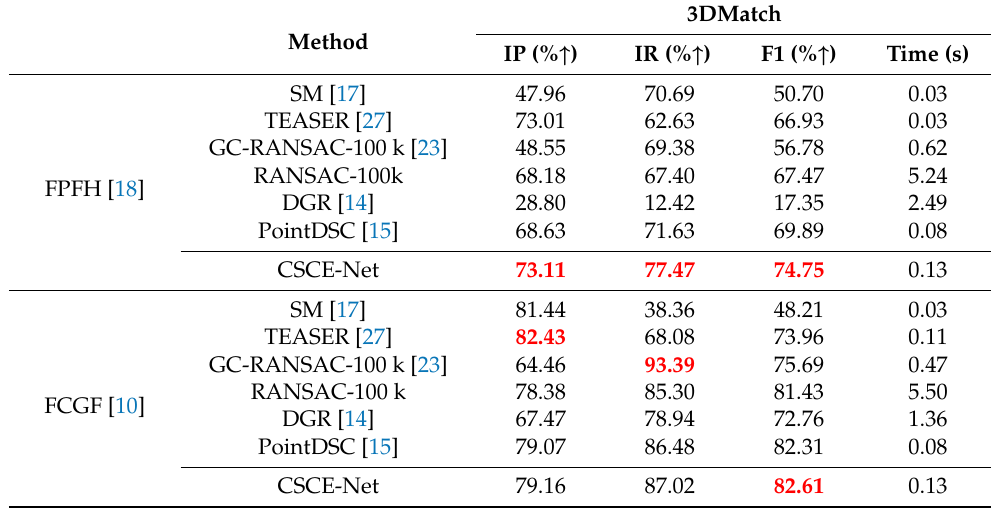
Table 1. Quantitative results of outlier rejection on the 3DMatch